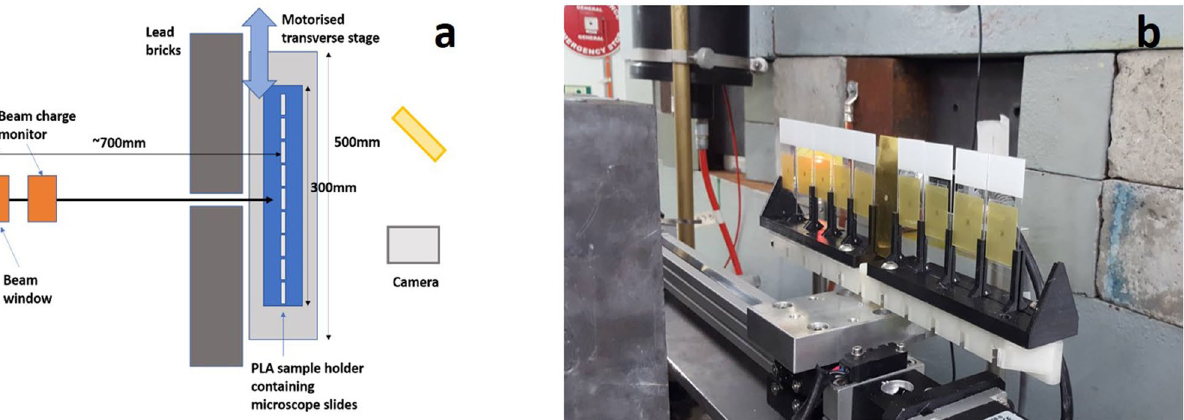
Figure 6. ( a ) Schematic (produced by author K.L.S.) and ( b ) photograph (taken by author K.L.S.) of experimental set-up for irradiation of dry plasmid samples on glass microscope slides. EBT-XD film placed behind samples to show sample coverage by beam.